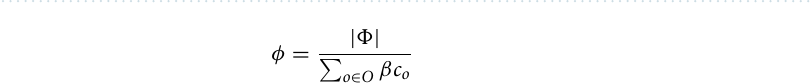
Figure 4. Mean maximum centrality, C max , of contact networks generated under varying α , β , and form of movement